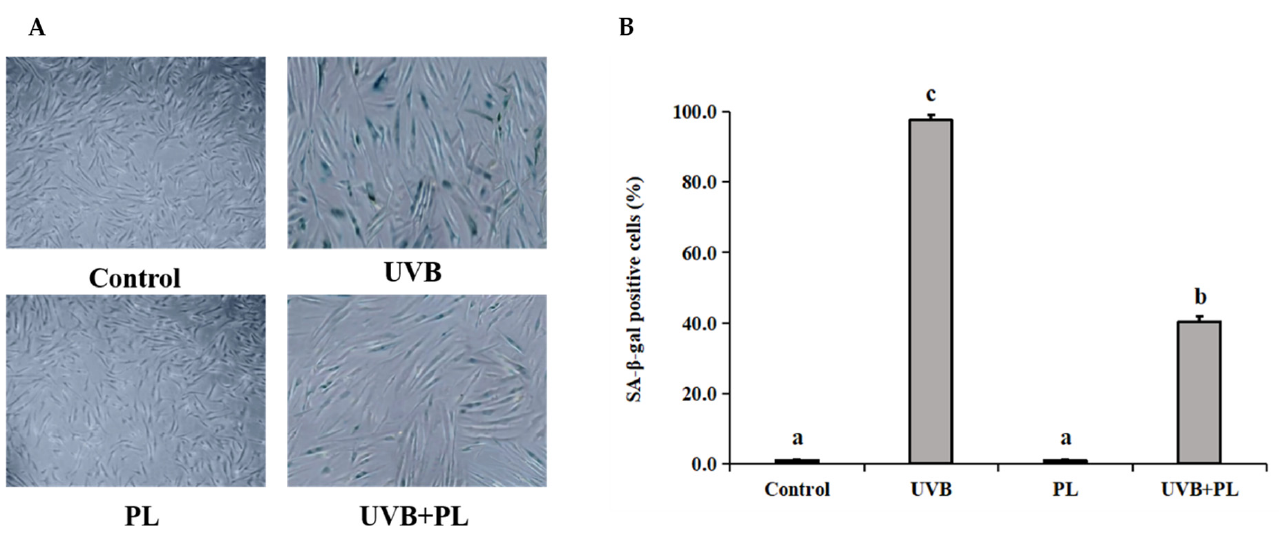
Figure 4. Effects of PL on the percentage of SA- β -gal positive NHDF cells. ( A ) and ( B ) the percentage of SA- β -gal positive NHDF cells, photomicrographs (×100) and bar diagram in NHDF cells. Results are expressed as the mean ± SD ( n = 3). Differences among the variables were assessed using Duncan’s multiple range tests. Values having different letters are significantly different ( p <